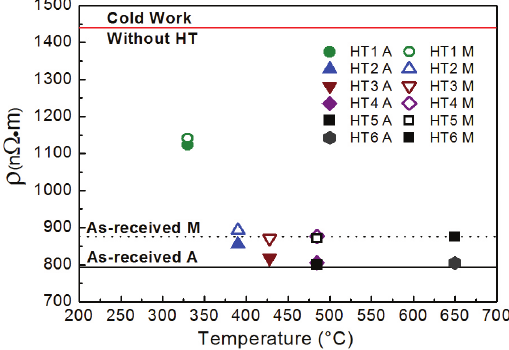
Figure 5. Electrical resistivity vs. HT temperature for austenite and martensite phases.